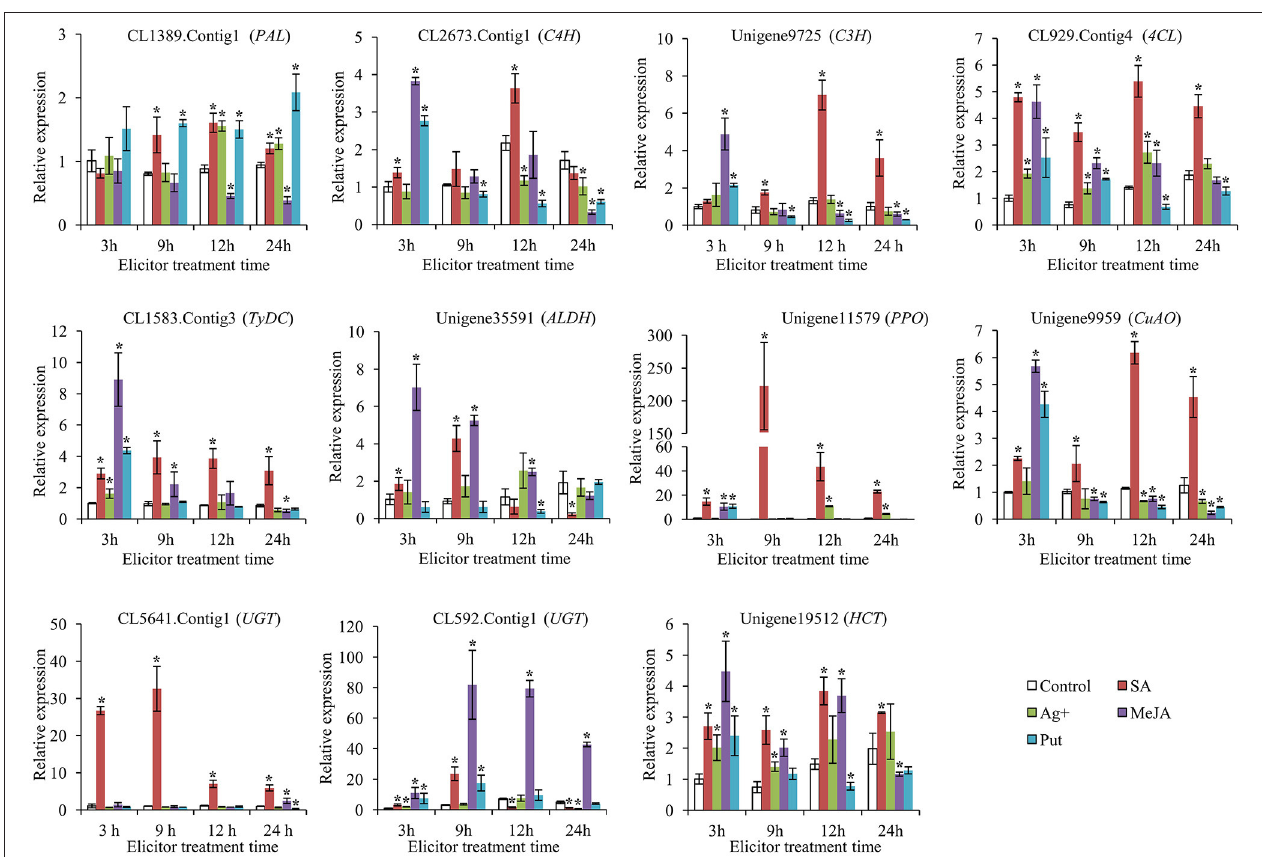
FIGURE 6 | Expression of key enzyme genes involved in biosynthesis of acteoside after SA, Ag + , MeJA, and Put treatments. These genes expression level were all determined by Real-time PCR. Vertical bars indicate the standard deviation of three biological replicates. Asterisks indicate a significant difference at the p < 0.05